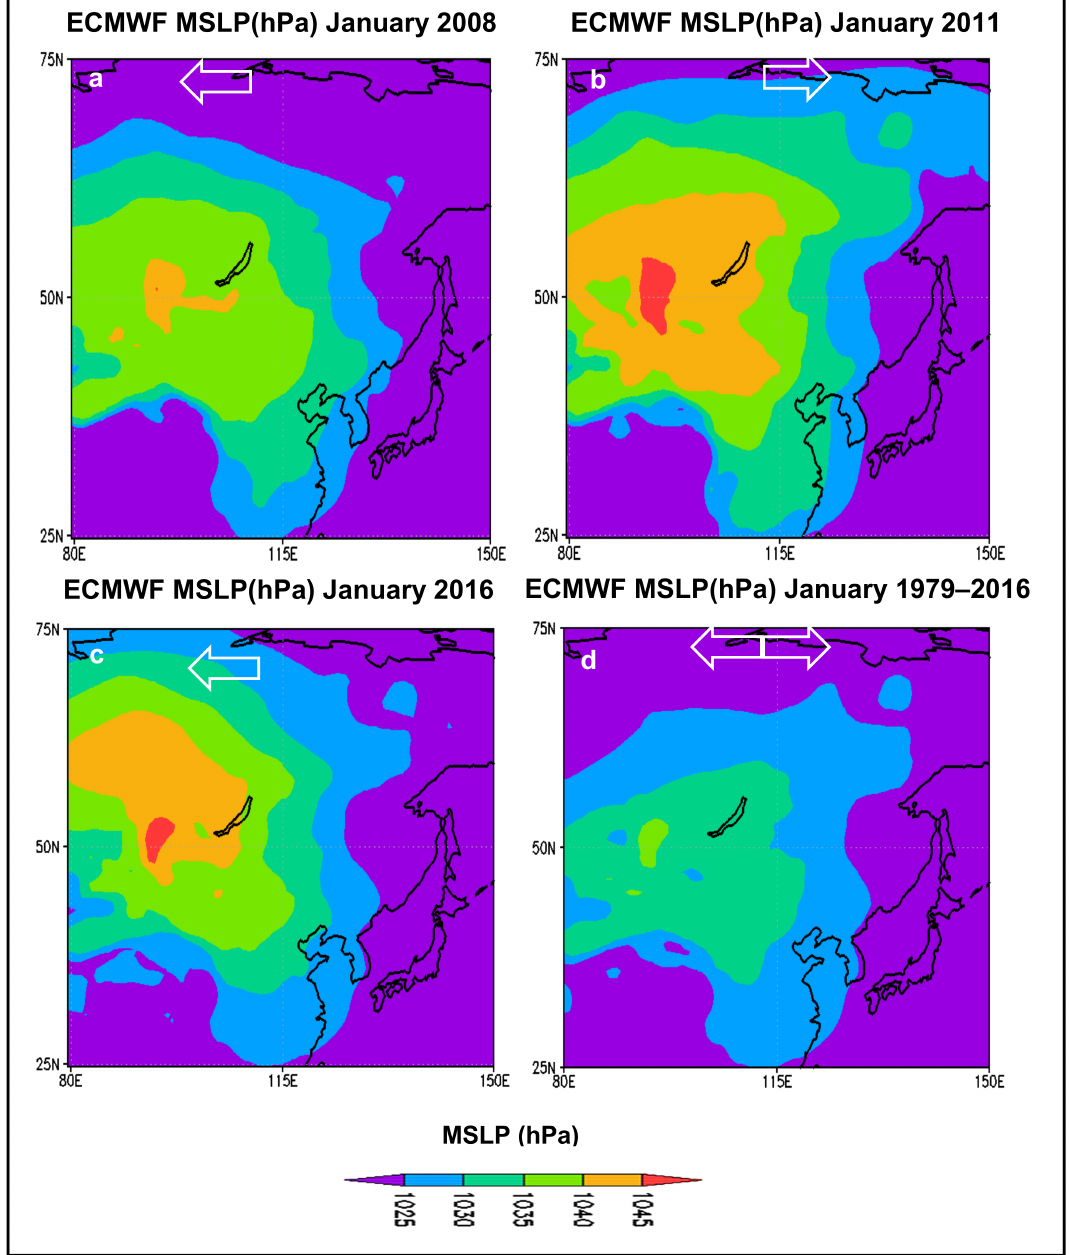
Figure 2. Monthly averaged MSLP over the SH for ( a ) January 2008; ( b ) January 2011; ( c ) January 2016; and ( d ) Annual mean MSLP for January over the SH for the period 1979–2016. White arrows indicate shifting of the SH system from the center (50 ◦ N, 100 ◦ E) of the domain. The coastal boundaries of Lake Baikal are represented by thick black lines. Data from the ECMWF,